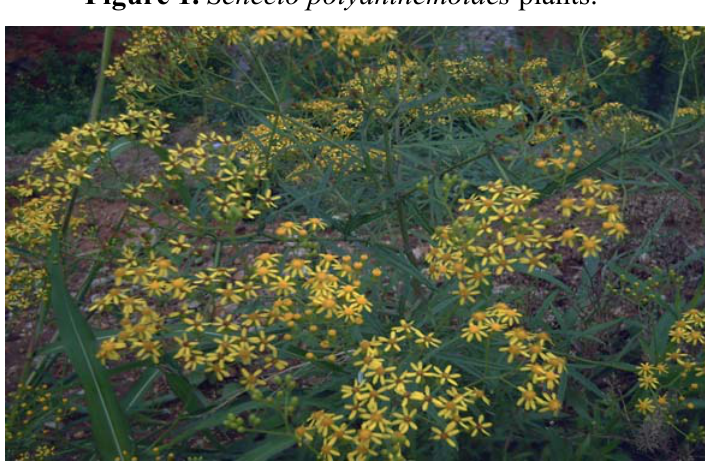
Figure 1. Senecio polyanthemoides